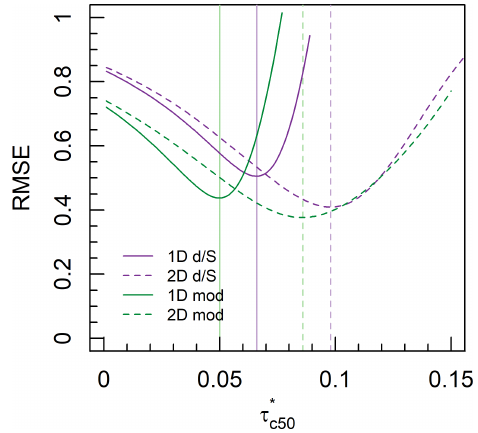
Figure 4. The correlation between q b and excess shear stress (in- dexed by RMSE) with varying critical dimensionless shear stress for each approach. A back-calculated critical dimensionless value is indicated where RMSE is lowest (Table